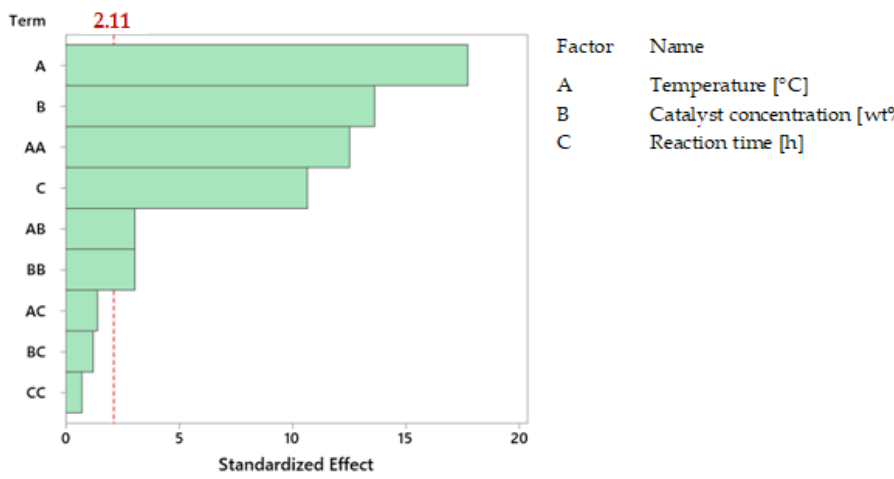
Table 2. Analysis of Variance of BP selectivity.